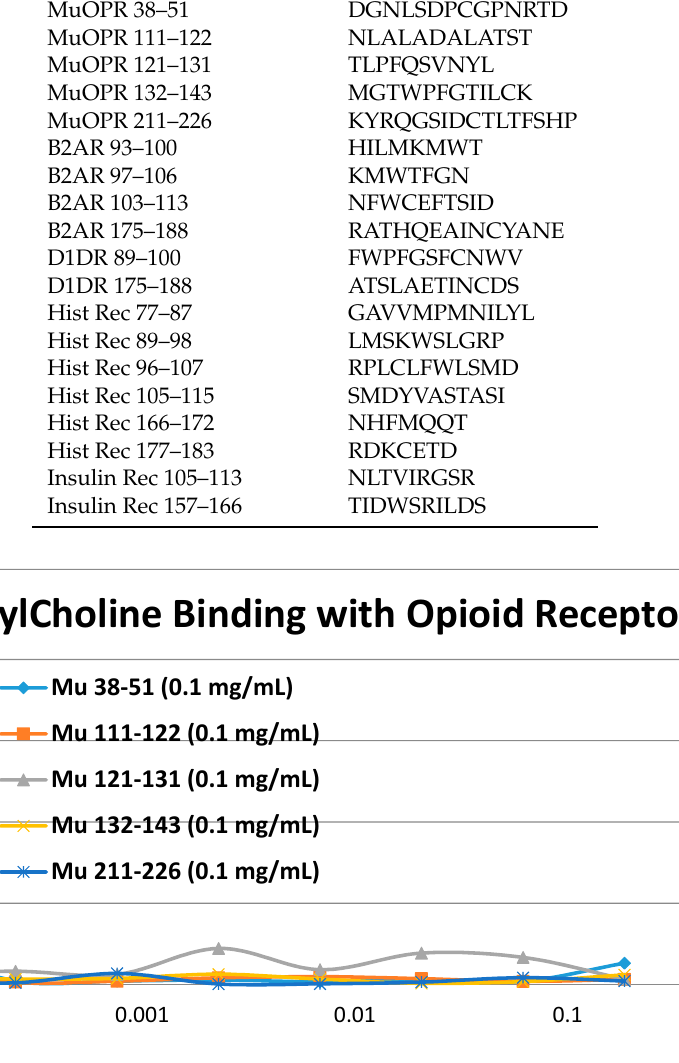
Figure 3. UV spectroscopic study of histamine binding to mu opioid receptor (muOPR) peptides derived from the extracellular loop and adjacent transmembrane regions (see Figure 1).